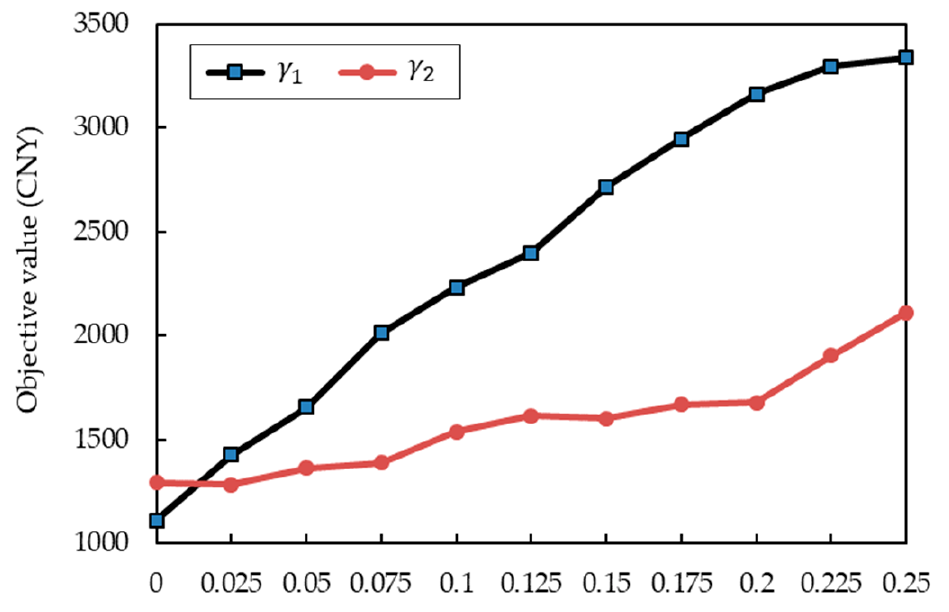
Figure 8. Relationship between the unit penalty cost and the objective value.